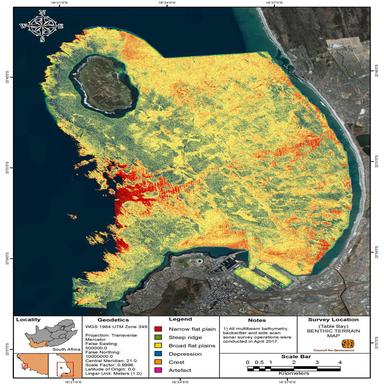
Final classification map of Table Bay, highlighting the most common seafloor features, which include narrow (associated with channels) and broad flat plains, channel scours, steep ridges, depressions and crests. The areas dominated by rock consist of steep ridges, crests and depressions, with broad and flat plains and channel scours found in the sand dominated areas of the Bay.